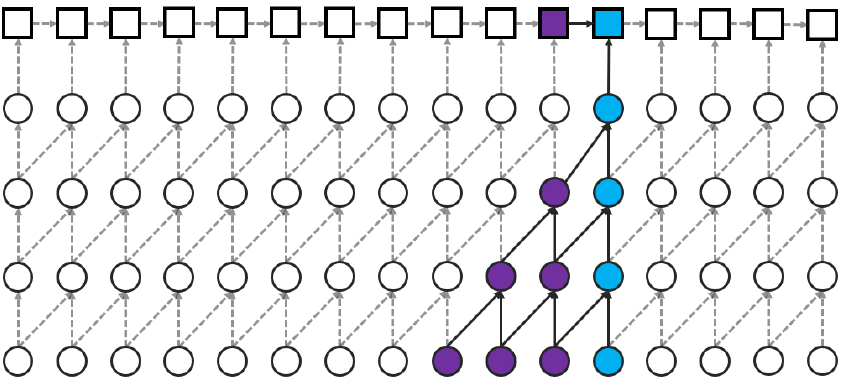
Figure 14. LRCN with causal CNN (SCLRCN) (Note: Purple denotes data used in the past currently required, blue denotes the number of nodes required by the current